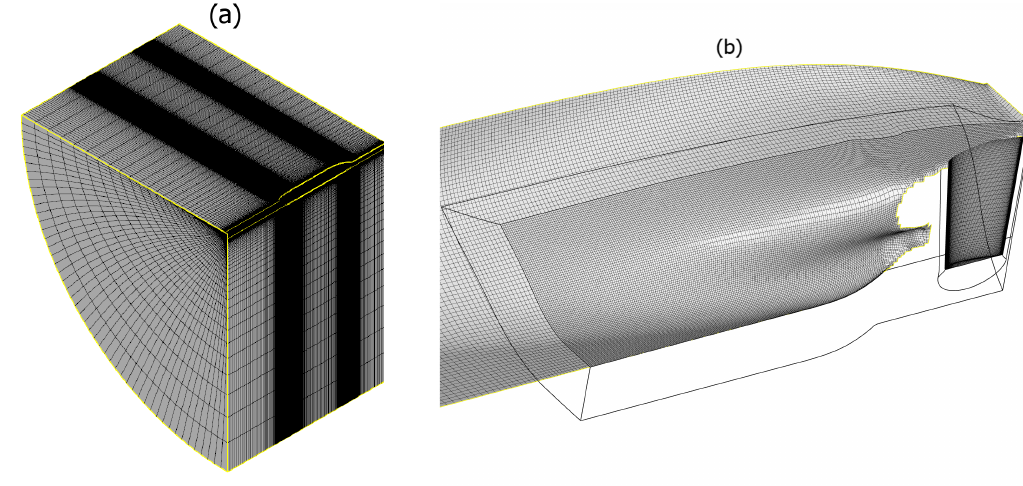
Figure 1. ( a ) Grid distribution of the coarsest grid, ( b ) grid refinement at the stern and the rudder as overlapping